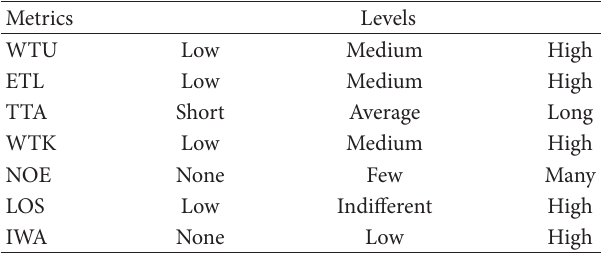
Table 1: Usability and acceptability